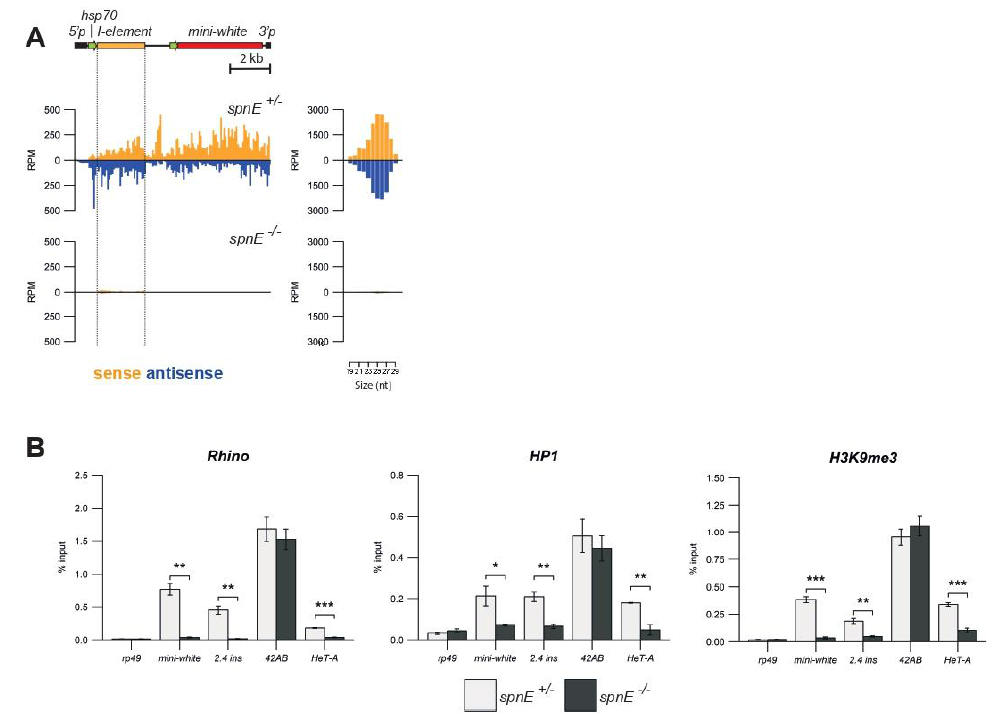
Figure 2. piRNA pathway disruption caused the loss of the heterochromatic state and piRNA production at transgenic piRNA clusters. ( A ) Normalized numbers of ovarian small RNAs (19-29 nt) mapped to transgenic constructs in hetero- and transheterozygous spnE mutants (brown—sense; blue—antisense; no mismatches allowed). The scheme of the I-TG transgene is shown above. The length distribution of transgenic small RNAs is shown to the right. ( B ) HP1, H3K9me3, and Rhi occupancy was estimated by ChIP-qPCR using primers corresponding to the indicated unique transgenic regions (* p < 0.05 to 0.01, ** p < 0.01 to 0.001, *** p < 0.001, t -test). Chromatin analysis of a unique region of the 42AB pericentromeric piRNA cluster and telomeric HeT-A retroelements was performed for comparison. The rp49 gene was used as a negative control. RPM, Reads Per Million.